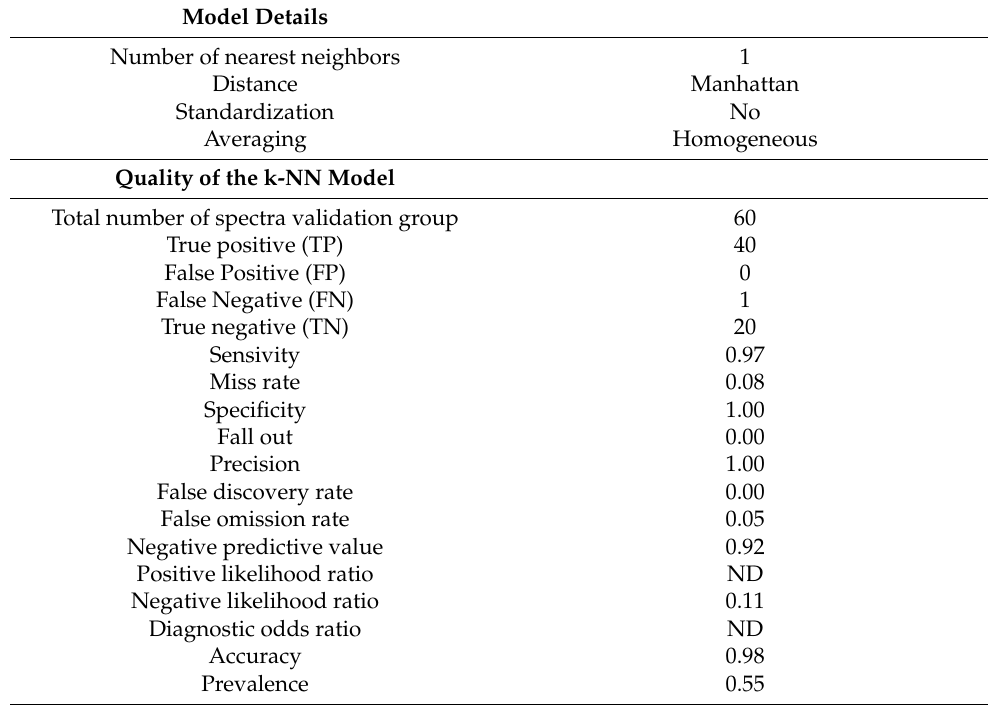
Table 5. The results of the k-NN model for differentiation of H. pylori infected